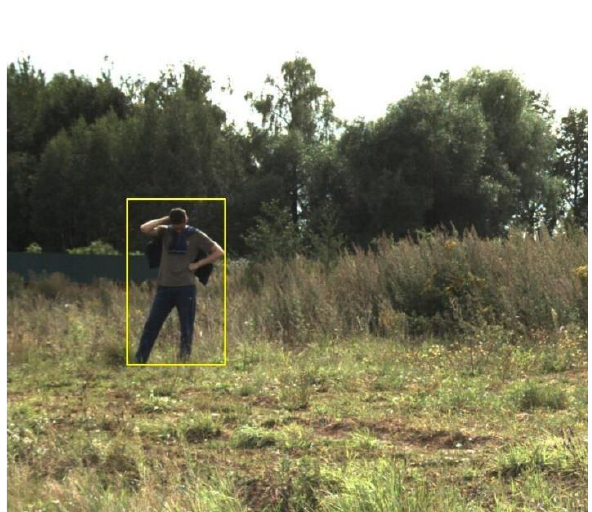
Figure 13. Detection results